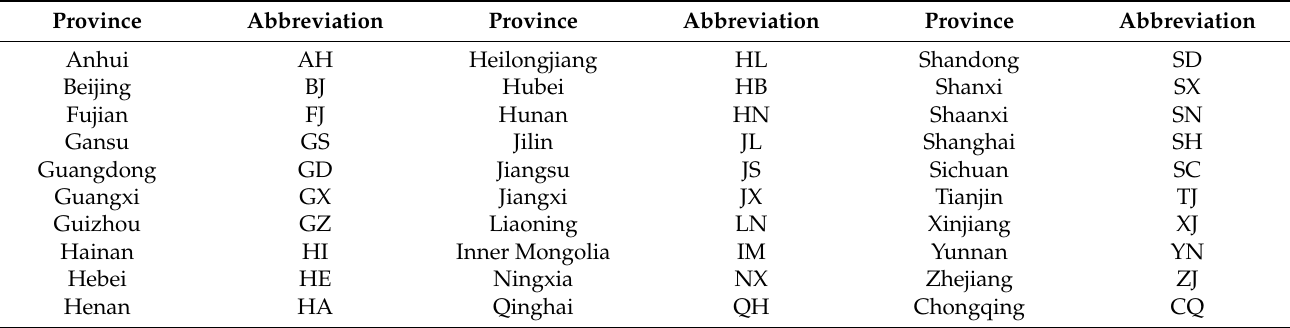
Table A1. The corresponding abbreviations of provinces in this